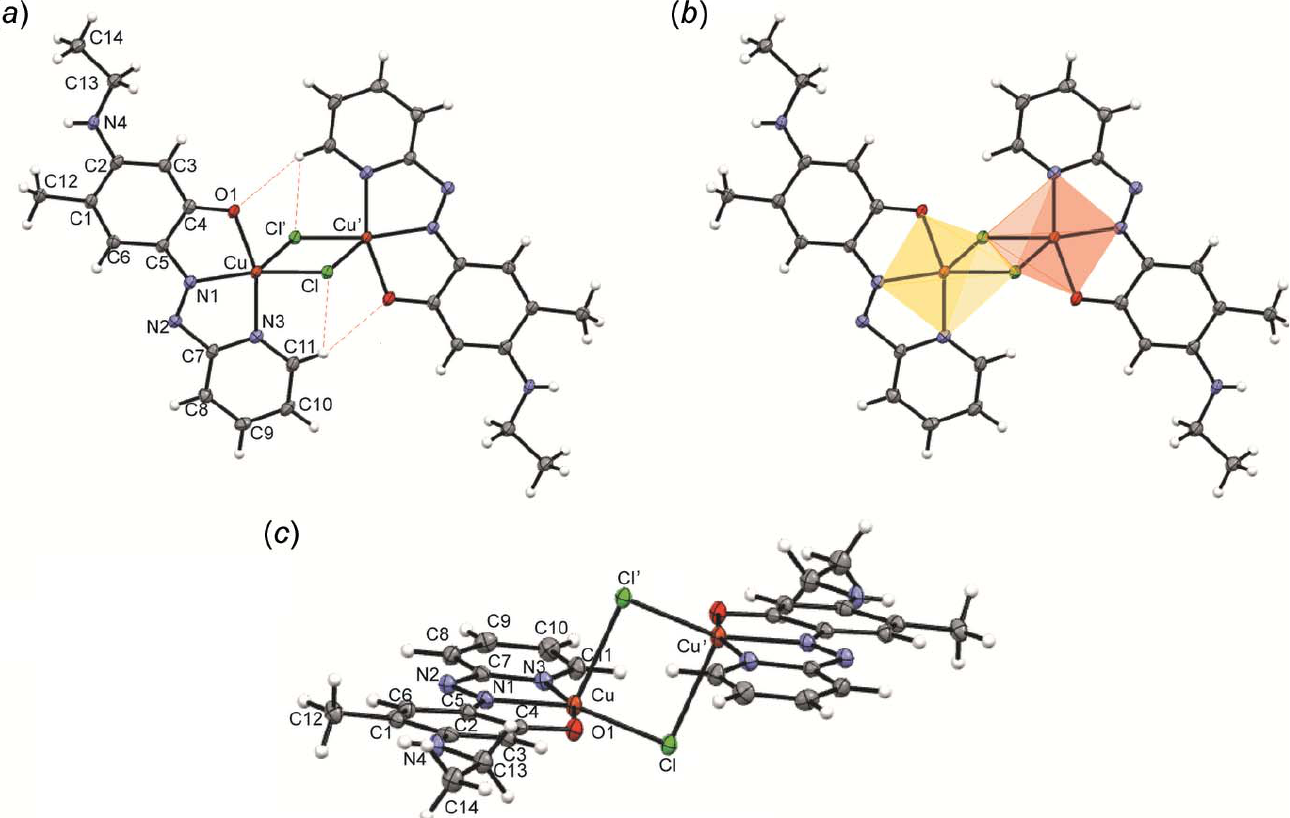
Figure 2 Molecular structure of 3 in different aspects ( a , c ), showing the coordination polyhedra of Cu ( b ) and intramolecular hydrogen bonds ( a ). Atomic displacement ellipsoids are drawn at the 50% probability level. Primed atoms are generated by inversion, symmetry operation 1 (cid:3) x , 1 (cid:3) y , (cid:3) z .